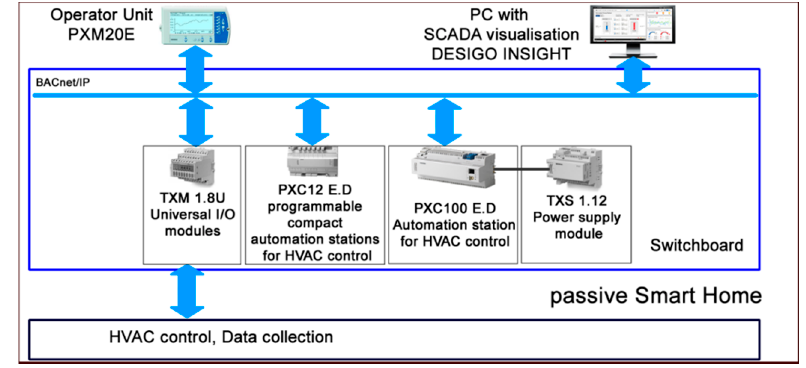
Figure 8. Block diagram of the BACnet technology used in an SH for HVAC control.